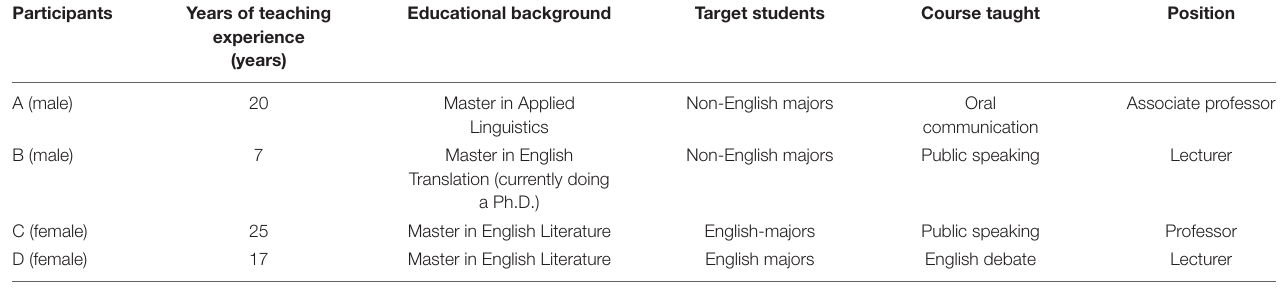
TABLE 2 | Overview of data